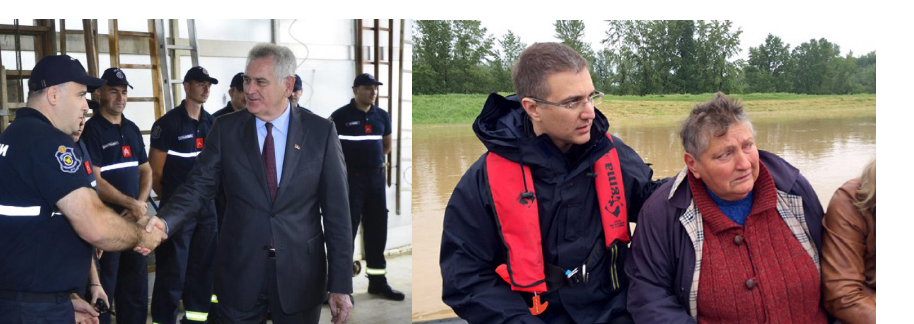
Figure 2c – Government support in emergency situations (floods in Obrenovac) Рис . 2 в – Государственная поддержка в чрезвычайных ситуациях ( наводнение в г . Обреновац )